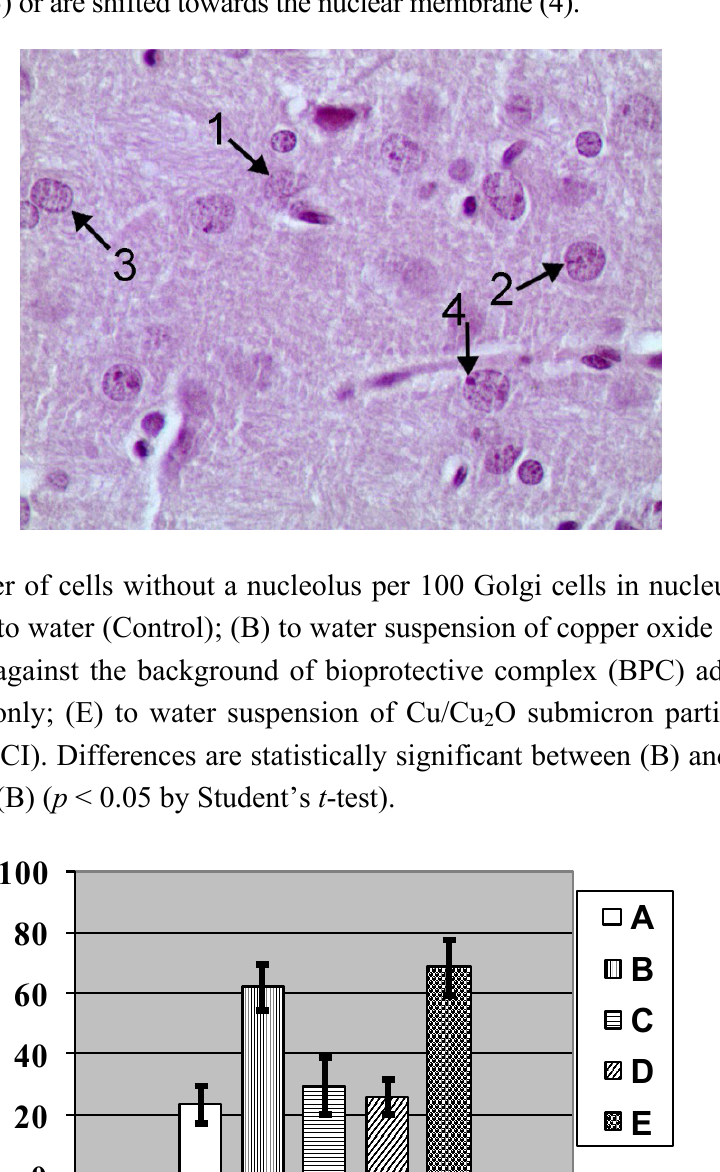
Neuron nuclei stain poorly, with an indistinct membrane (1), the nucleoli are pycnotic (2), are often absent (3) or are shifted towards the nuclear membrane (4).